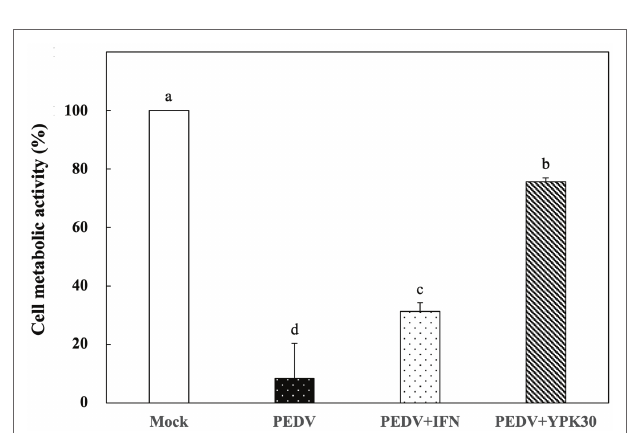
FIGURE 5 | In vitro therapeutic effects of the intracellular extracts of Ln. mesenteroides YPK30 against PEDV infection in Vero cells. Bar chart showing percentage of cell metabolic activity of four sample conditions: (1) Mock: cells mock-infected with PBS and then treated with PBS, (2) PEDV: cells infected with PEDV and then treated with PBS, (3) PEDV+IFN: cells infected with PEDV and then treated with IFN- α 2b, and (4) PEDV+YPK30: cells infected with PEDV and then treated with the intracellular extracts of Ln. mesenteroides YPK30. All data are expressed as mean ± SD ( n = 3). Bars marked with the same letter are not significantly different ( p >